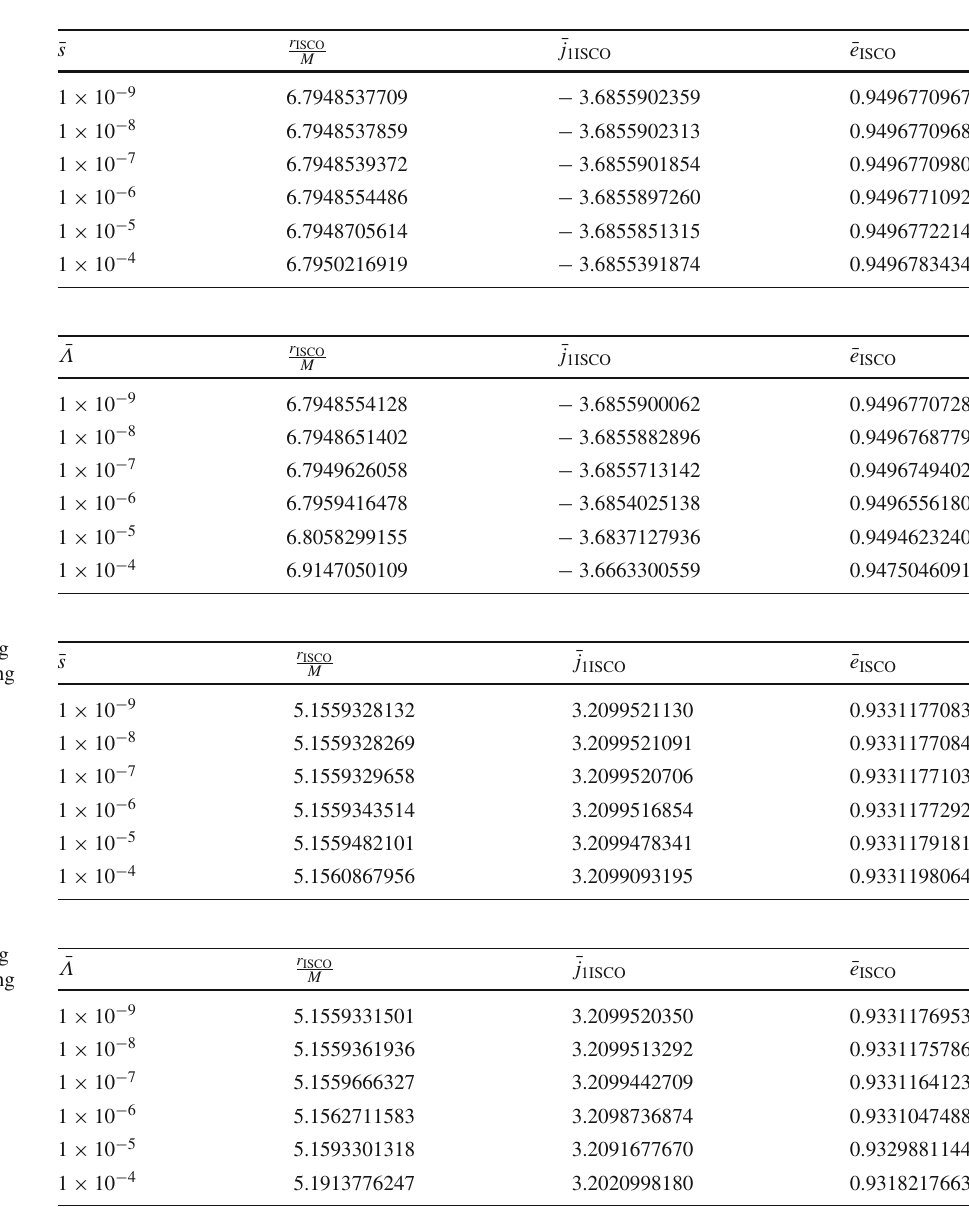
with mass m ek ∼ 10 M (cid:3) , the corresponding spin